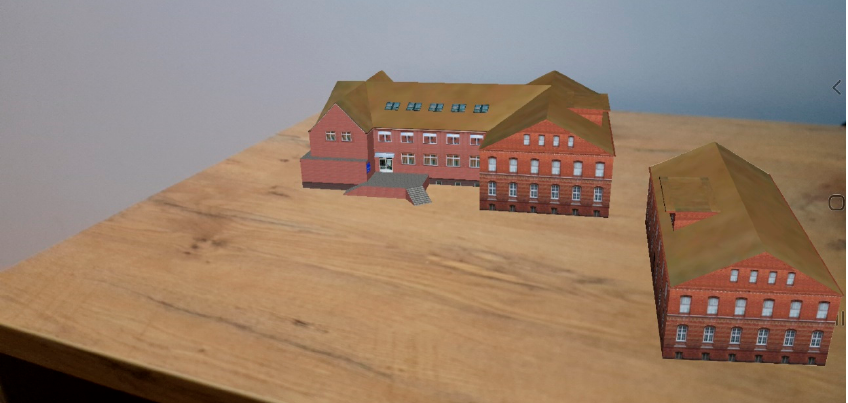
Figure 18. Visualization of temporal changes of the Dean's Office of the Faculty of Geoengineering building (at the top 3D model of current look of the building, on the right model from 1976).